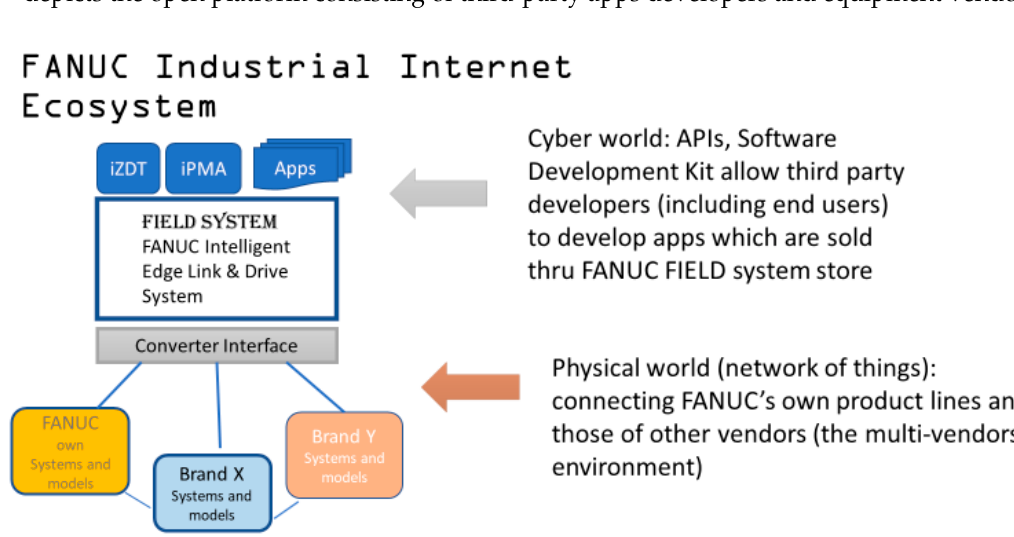
Figure 4. A Layered Structure of the FIELD system (FANUC); Source: FANUC corporate materials on the Internet) and the Industrial Internet ecosystem (Authors’ rendition).